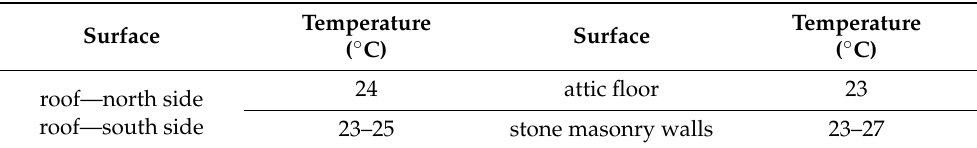
Table 6. Surface temperatures at 6:00 p.m. obtained from BPS